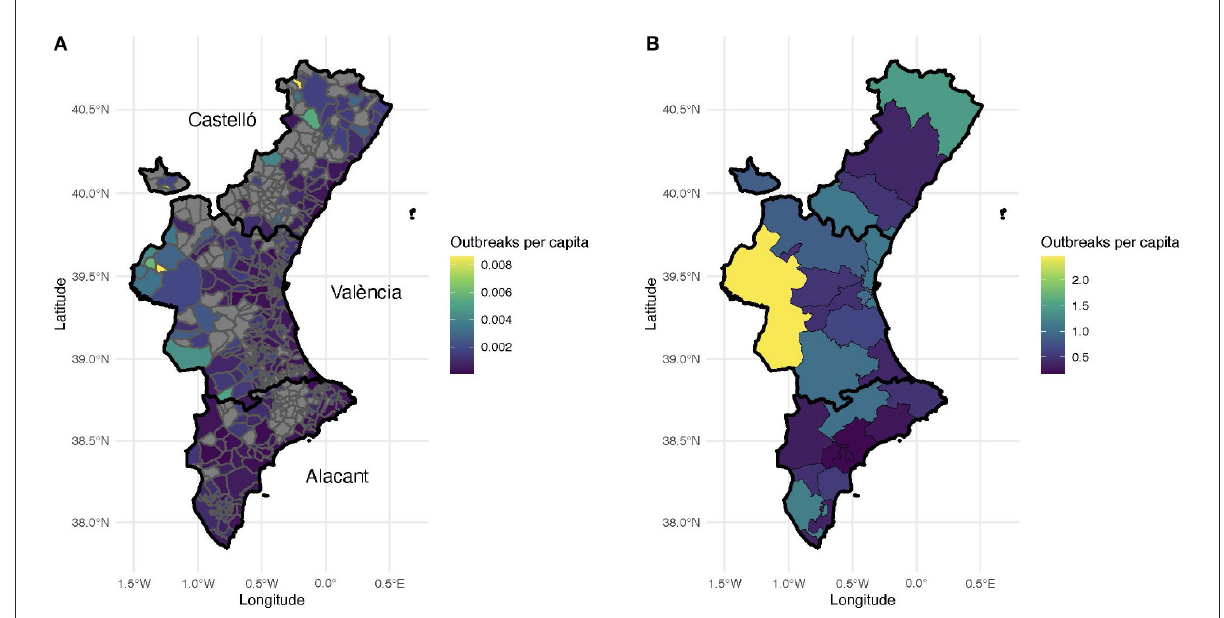
FIGURE3 Number of outbreaks per thousand inhabitants. (A) Number of outbreaks per municipality. Municipalities without recorded outbreaks are displayed with gray color. Each province is outlined with a black contour. (B) Number of outbreaks per health